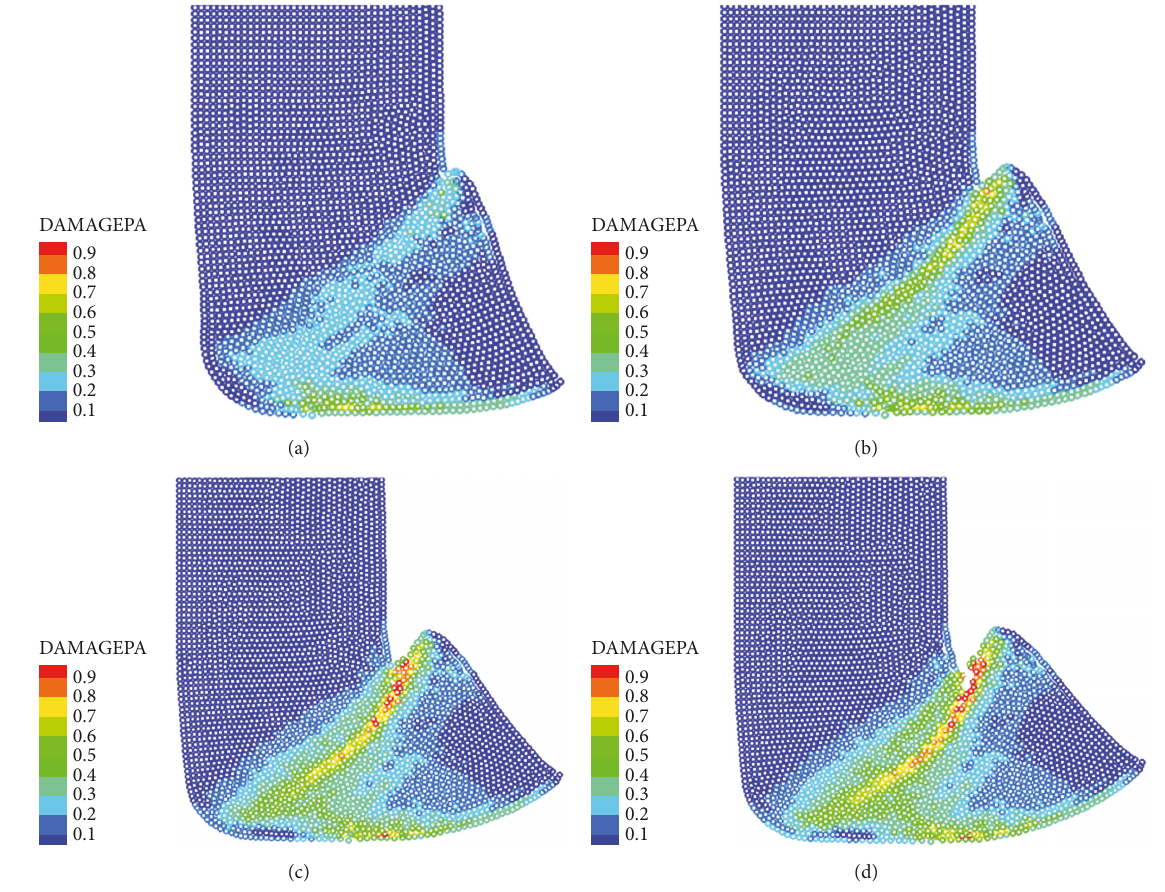
Figure 6: Simulation results of accumulated damage value distribution. Table 1: Parameters for constitutive model of pure